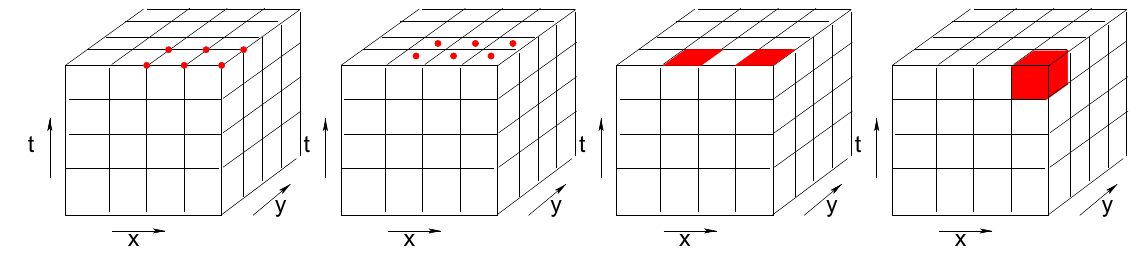
Figure 1. Different meaning of cells in spacetime